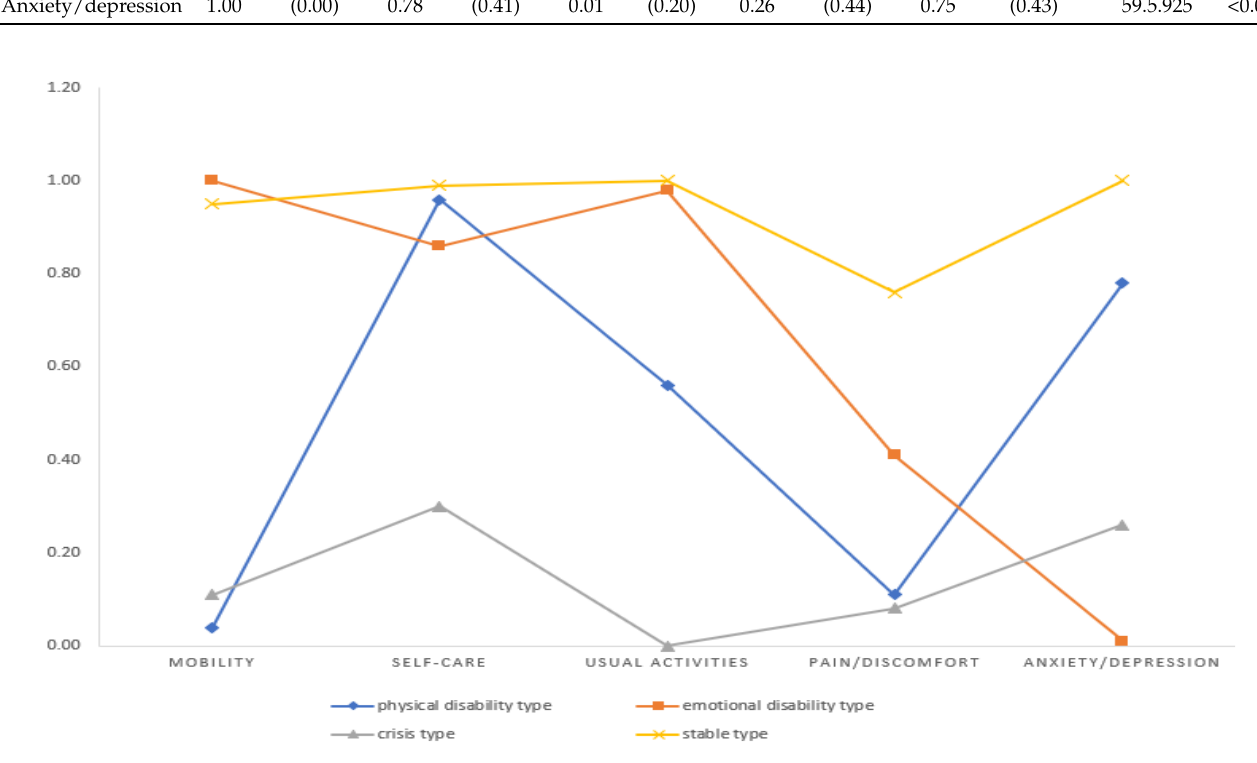
Figure 1. Latent classes of health-related quality of life.